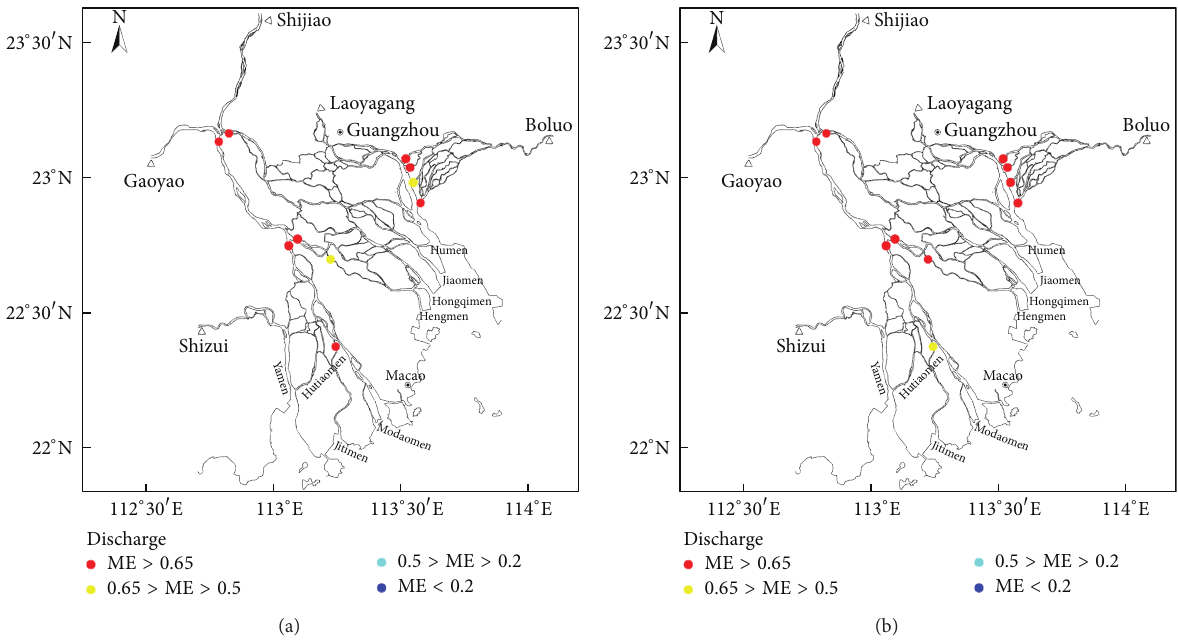
Figure 6: (a) The calibration of discharges from July 18 to July 19, 1998. (b) The validation of discharges from February 7 to February 16, 2001.